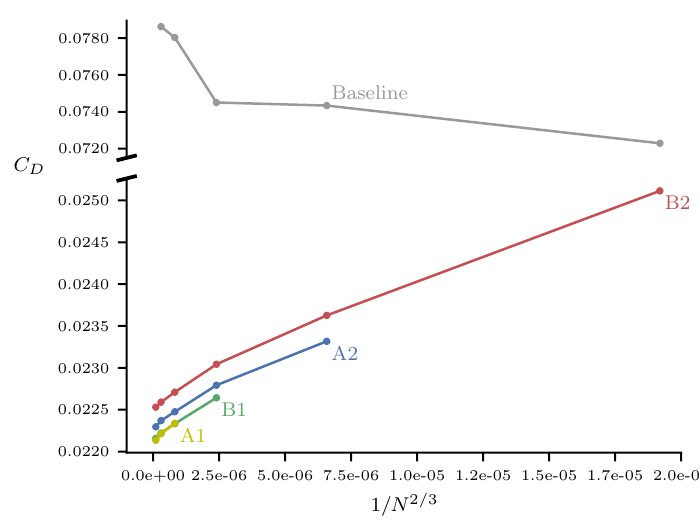
Figure 10. Drag convergence study for the baseline and single-point optimized wings. For the baseline wing, the drag increases as the mesh is refined because the shock is resolved more accurately on finer meshes. The improvements to the optimized wings are preserved as the mesh is refined.